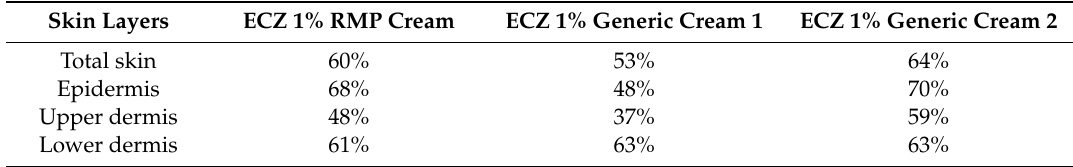
Table 2. Variability of ECZ deposition in the di ff erent porcine skin layers for each formulation presented as % RSD values ( n =